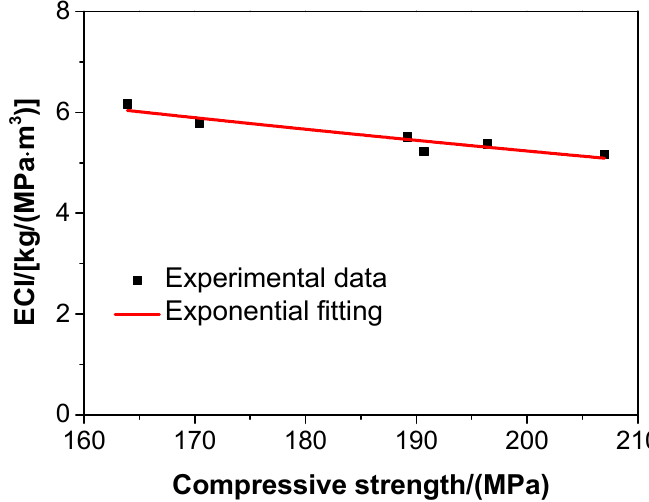
Figure 10. The relationship between the compressive and embedded CO 2 index of the UHPC.